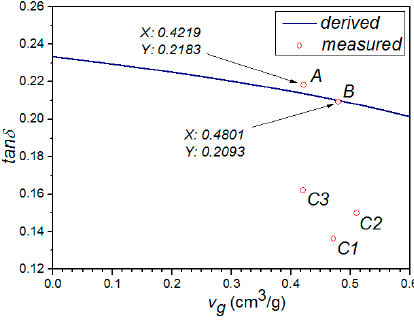
Figure 3. Theoretical and experimental comparison graph between tan δ ( ε eff ) and v g .